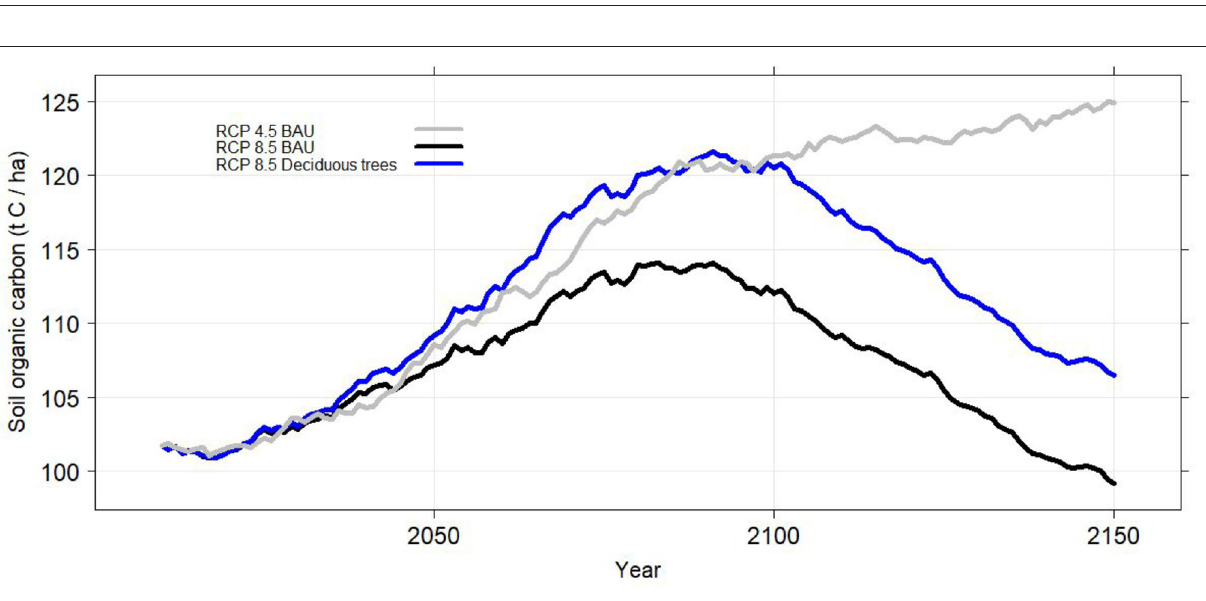
FIGURE 7 | Temporal trend of the soil organic carbon stock of Austrian soils in a simulation experiment. The scenarios are a moderate temperature increase (RCP 4.5 Business-as-usual forest management), and a strong warming trend (RCP 8.5 Business-as-usual forest management, and RCP 8.5 replacement of coniferous forests with deciduous forests). The y-axis ranges from 100 to 125 t